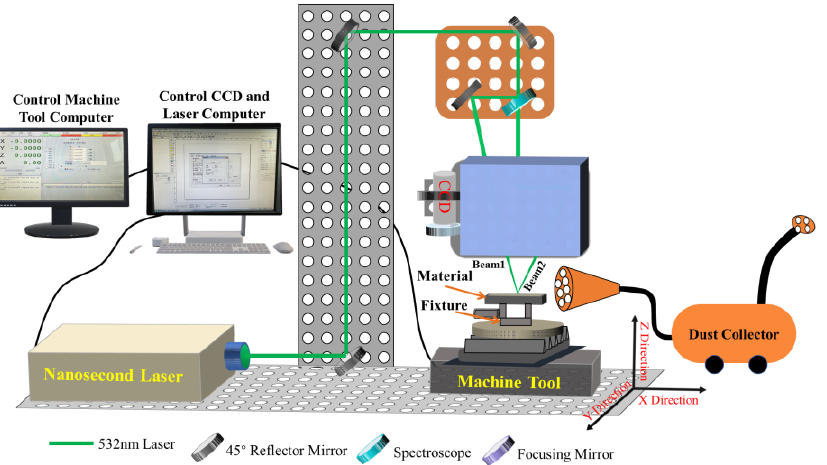
Figure 1. Schematic diagram of dual-beam coupled nanosecond laser processing system .